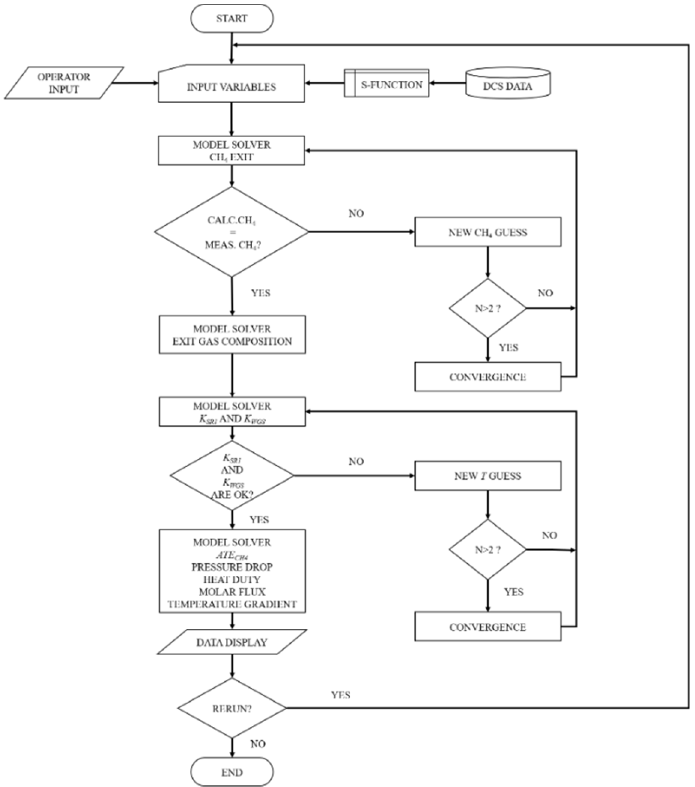
Figure 4. Model logic flow diagram.